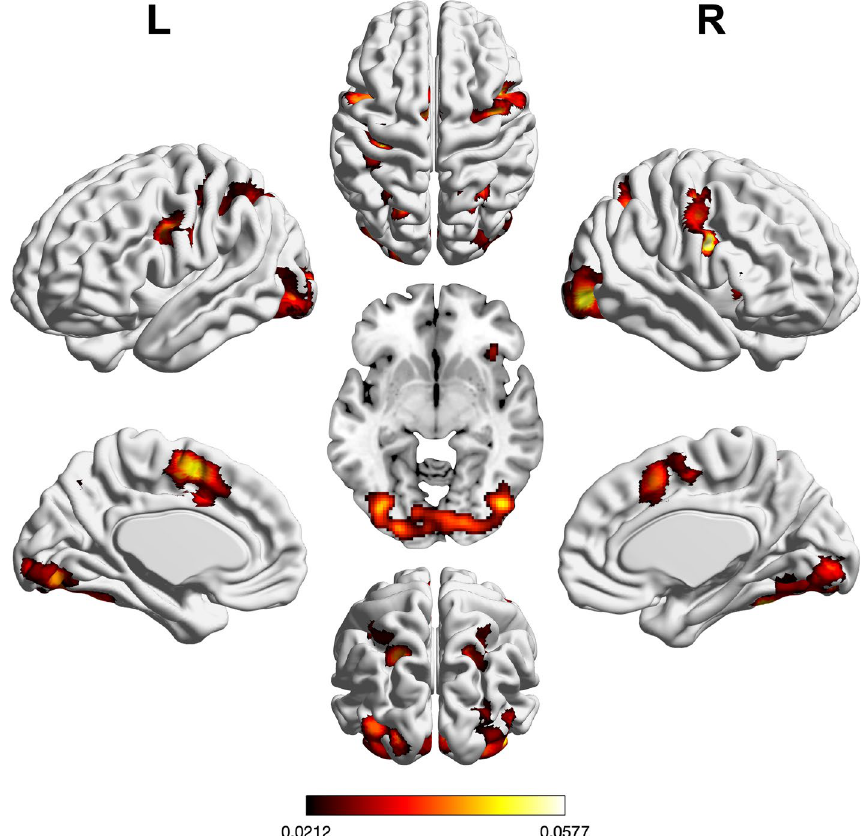
Figure 2. Foci of brain activity showing significant across-experiment convergence of activity related to visual processing (cluster-level p < 0.05, family-wise error-corrected for multiple comparisons, cluster-forming threshold at voxel level: p < 0.001). The scale bar reflects activation likelihood estimation scores. Cortical and cerebellar clusters of convergence were visualized with the BrainNet Viewer 24 ; subcortical clusters were rendered on the individual anatomical template (“ch2better”) provided with MRIcron 25